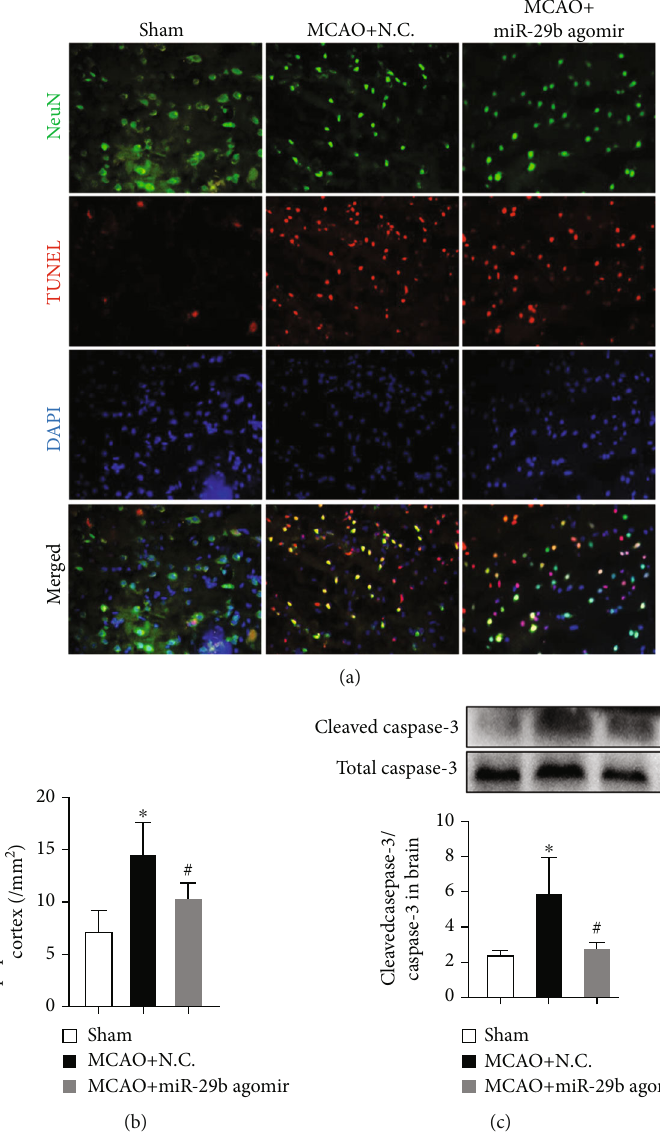
Figure 3: miR-29b inhibited the neuronal apoptosis after MCAO in rats. (a and b) Neuronal apoptosis in the ipsilateral cortex detected by NeuN/TUNEL immuno fl uorescence double staining. N = 6 . (c) Immunoblot of caspase-3 in the ipsilateral brain of MCAO rats. N = 6 . ∗ P < 0 : 05 vs. sham group. # P < 0 : 05 vs. MCAO+NC